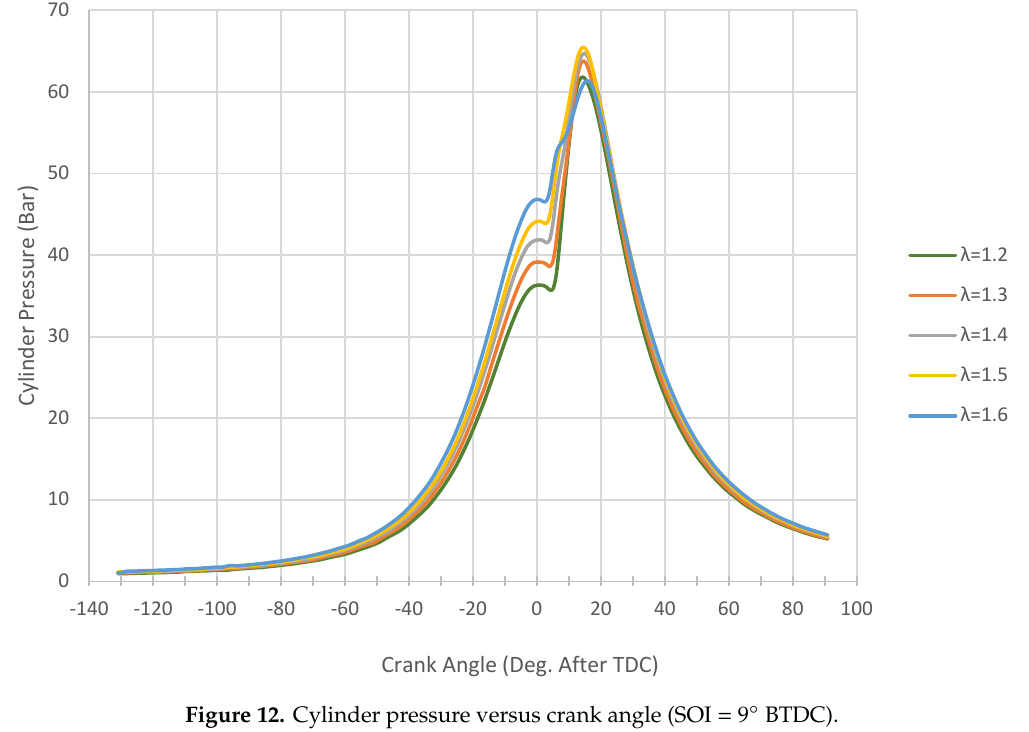
Energies 2019 , 12 , x FOR PEER REVIEW Figure 12. Cylinder pressure versus crank angle (SOI = 9 ◦ BTDC). Figure 12. Cylinder pressure versus crank angle (SOI = 9° BTDC).